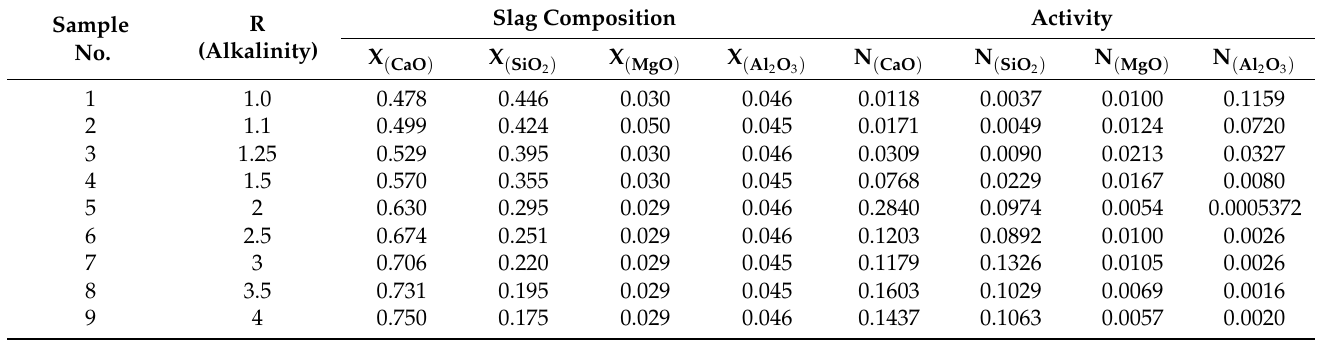
Table 4. Effect of alkalinity on the activity of components in the CaO-Al 2 O 3 -SiO 2 -MgO system.